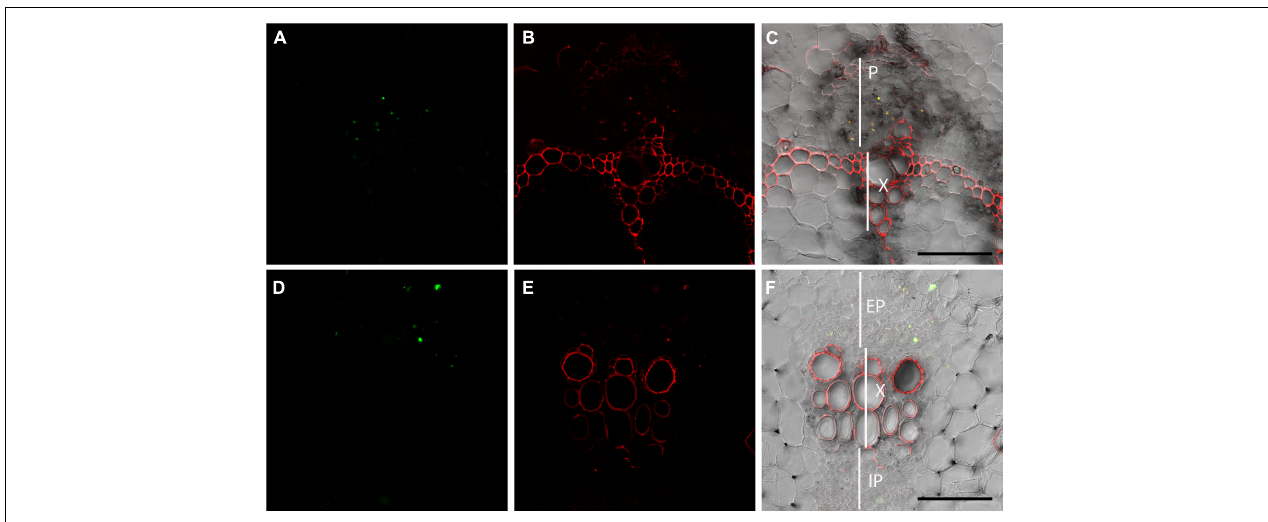
FIGURE 5 | Dual labeling of P-proteins with OGA 488 and SR101 in snap bean and cucumber transverse stem sections. (A–C) Transverse sections of snap bean ( Phaseolus vulgaris ) labeled with OGA 488 (green signal in A ) and SR101 (red signal in B ) shows colocalization within the phloem (yellow signal in C ) but SR101 labels additional cell walls within xylem and phloem. (D–F) Transverse sections of cucumber ( Cucumis sativus ) labeled with OGA 488 (green signal in D ) and SR101 (red signal in E ) shows colocalization within the external phloem (yellow signal in C ) but SR101 labels additional cell walls within xylem and phloem. EP, external phloem; IP, internal phloem; P, phloem; X, xylem. Scale bars 100 µ